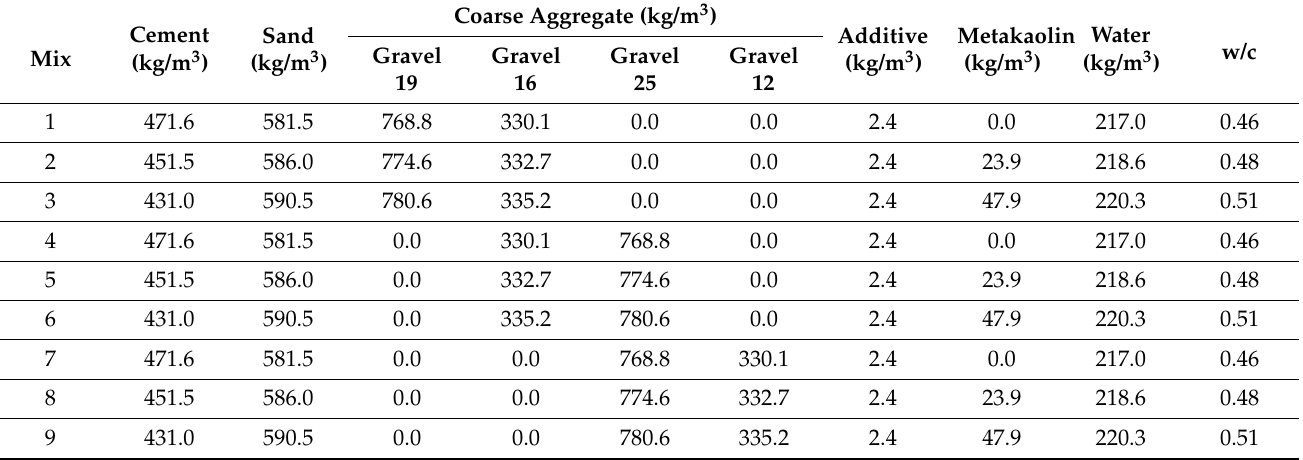
Table 1. Mixture proportions of the specimens tested.